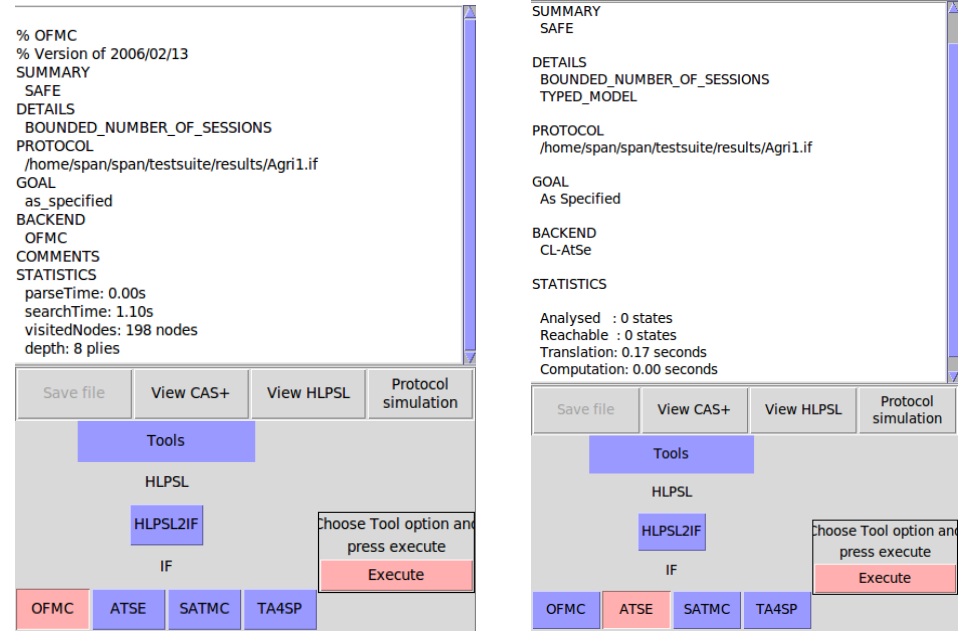
Figure 17. The simulation results using OFMC and CL-AtS back-ends in Case 2. Table 3. Comparison of security